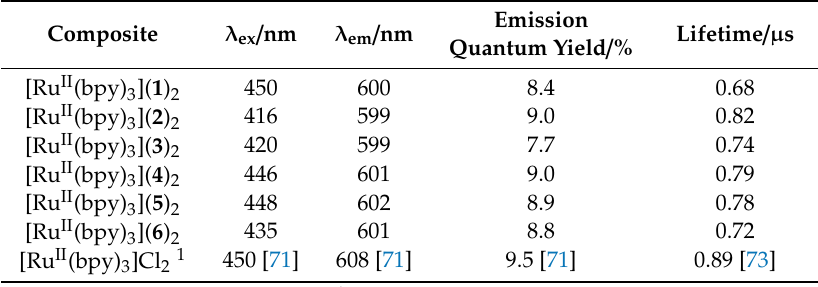
Table 1. Luminescence spectral data, emission quantum yield, and lifetime of [Ru II (bpy) 3 ](lipid) 2 (lipid = 1 – 6 ) complexes in EtOH at 298 K [[Ru II (bpy)